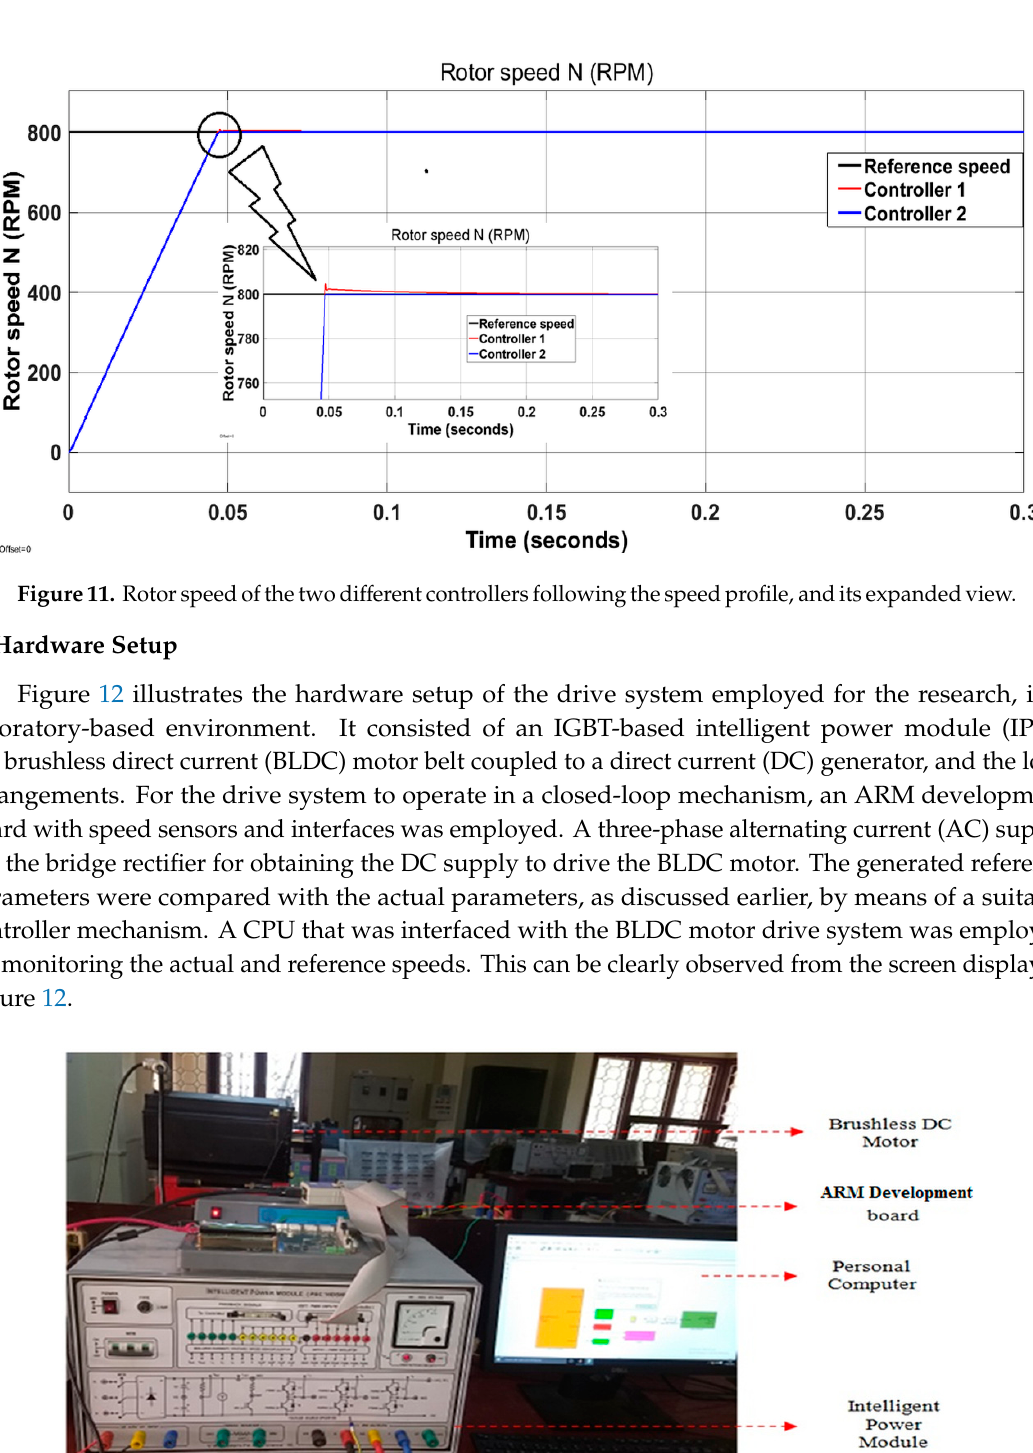
Figure 12. Brushless DC motor drive hardware arrangements.